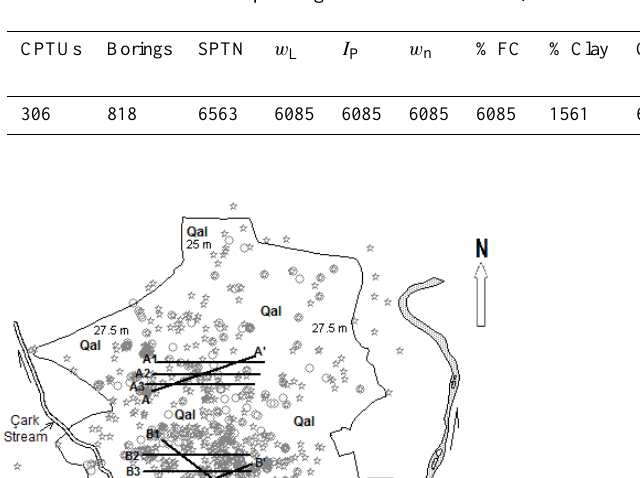
Table 1. Features of the Adapazarı geotechnical database (number of data available).